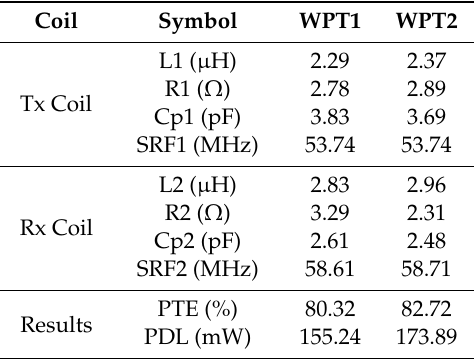
Table 4. Measured coils’ electrical specification.